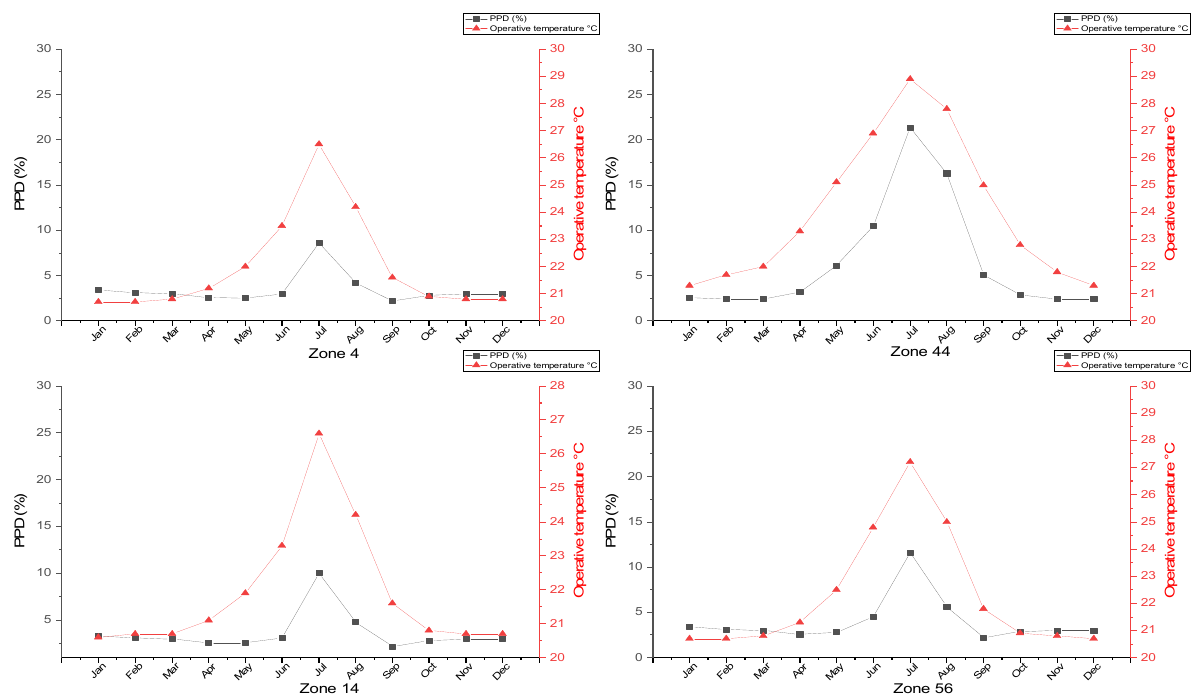
Figure 21. Monthly predicted percentage of dissatisfied (PPD (%)) and operative temperatures for zone 4, zone 14, zone 44 and zone 56 in case B (with low-E film).